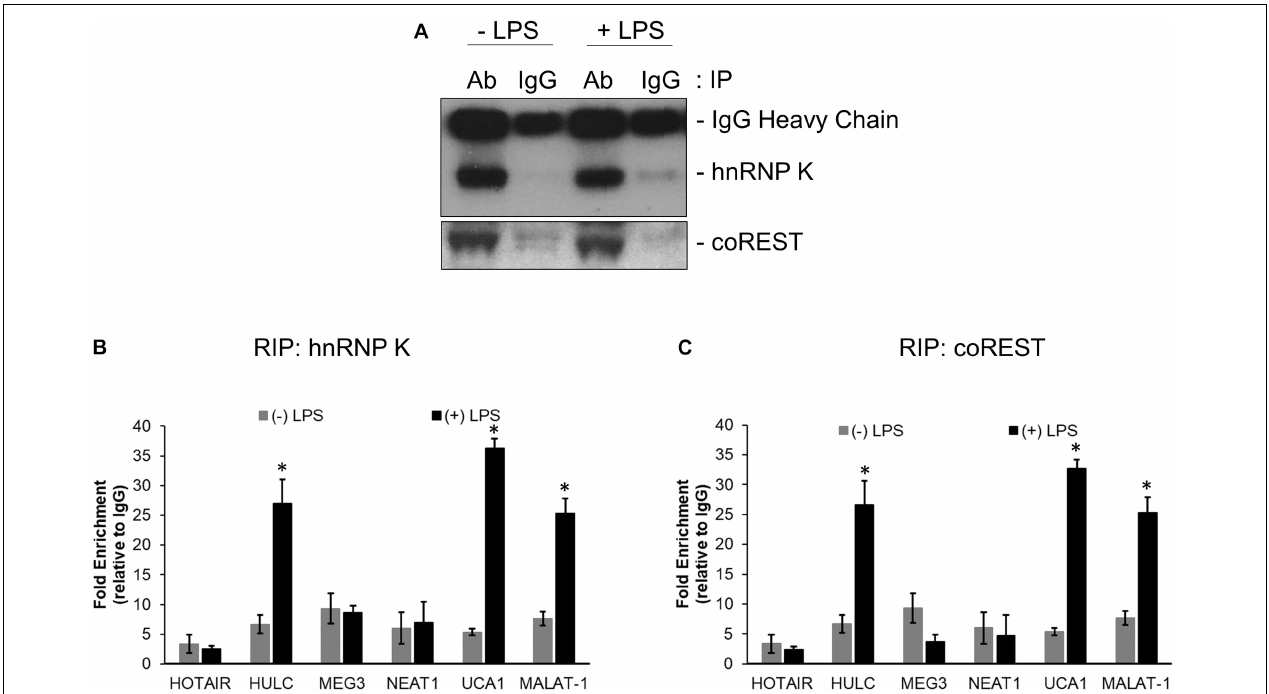
FIGURE 2 | HULC, UCA1, and MALAT-1 lncRNAs were upregulated following LPS induced sepsis in HMECs. Nuclear extracts prepared from untreated or LPS treated HMECs were subjected to immunoprecipitation using anti-hnNRP K and anti-coREST (A) antibodies. RNA was isolated from immunoprecipitates and subjected to quantitative RT-PCR to detect relative enrichment of indicated lncRNAs in anti-hnRNP K immunoprecipitate (B) and anti-coREST immunoprecipitate (C) , compared to IgG immunoprecipitates. Data represent relative enrichment compared to IgG precipitates. ∗ P < 0.05 compared to untreated cells.